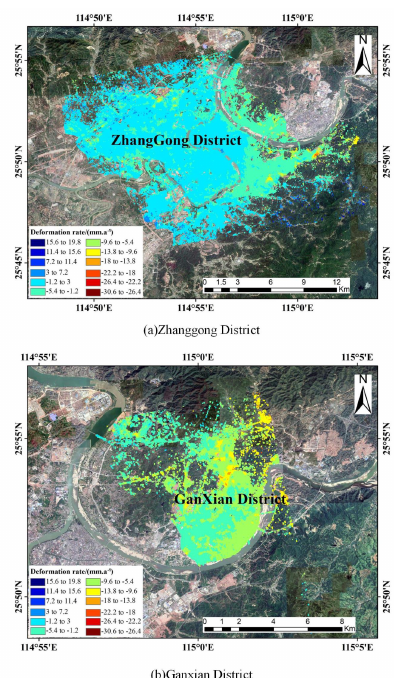
Figure 5. Comparison between surface subsidence profiles of Zhanggong District and Ganxian